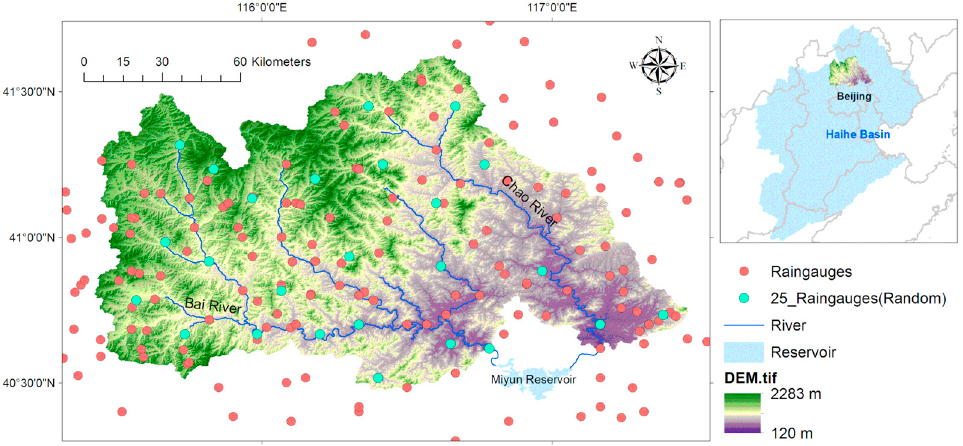
Figure 1. The study area.